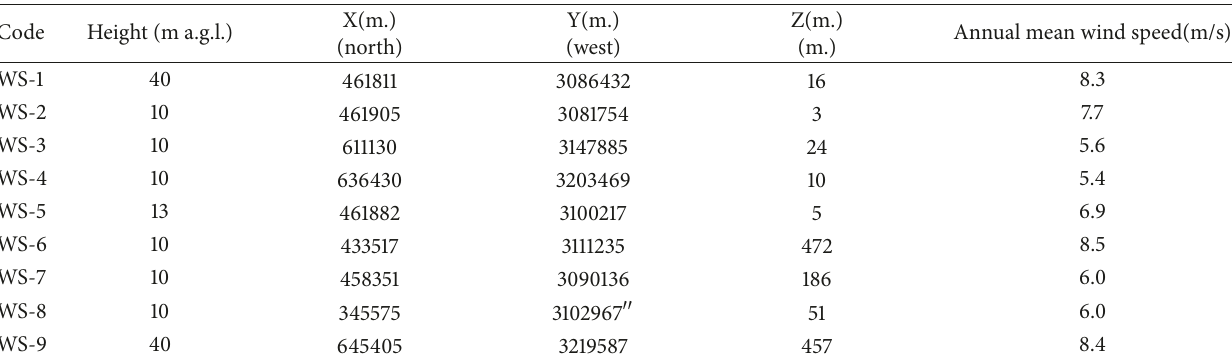
Table 2: Weather stations used in the